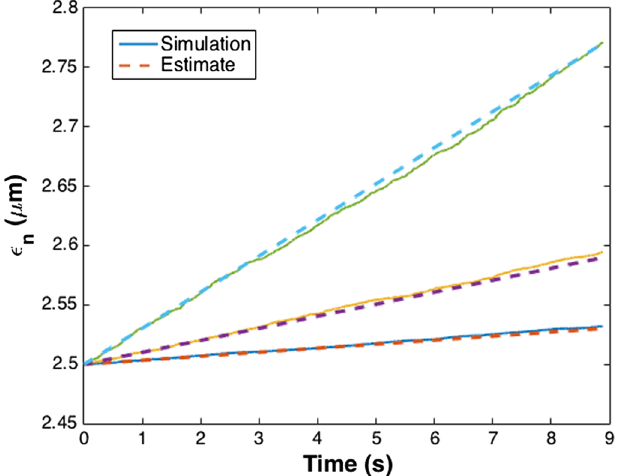
FIG. 15. Multiple simulation runs for the same phase noise PSD (solid lines). Theoretically estimated trend line (dashed line).